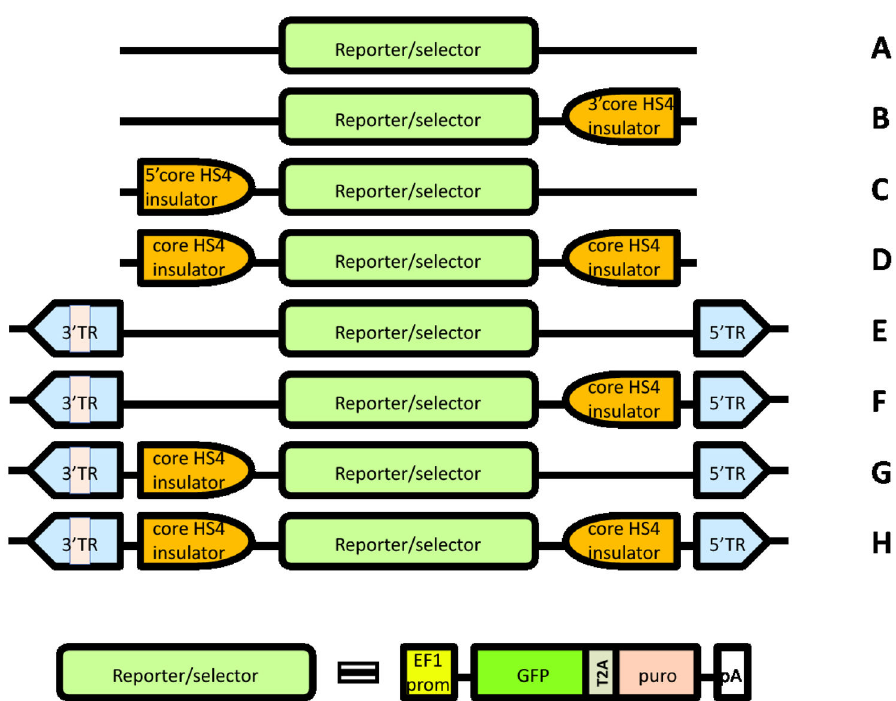
Figure 1. Schematic representation of GFP reporter constructs. The constructs A through H were inserted into pSMART, resulting in pS A through pS H plasmids,